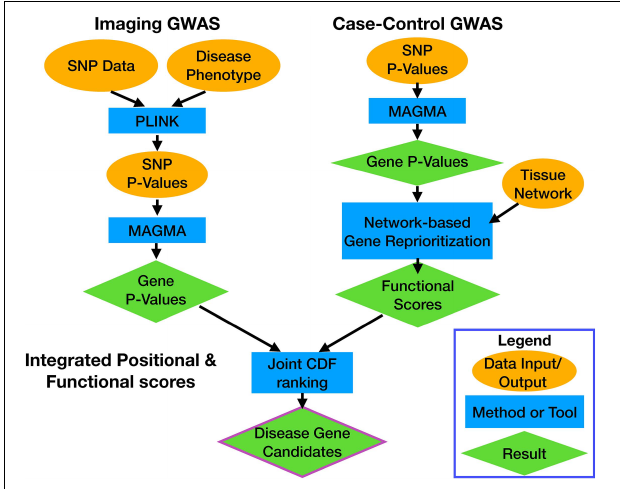
FIGURE 1 | Workflow overview. Each data stream, and the calculation of the integrated score, are indicated by the bolded labels. Each section shows how data (orange ovals) were processed by computational tools (blue rectangles) to get results (green diamonds). Arrows indicate flow of information through the